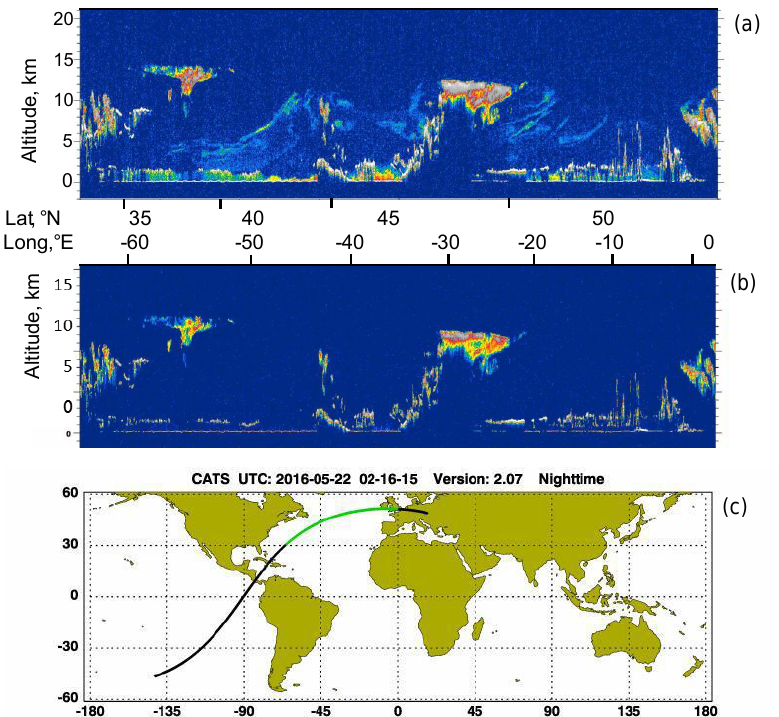
Figure 17. The total attenuated backscatter (a) and perpendicularly polarised backscatter (b) signals from the CATS lidar around 02:16 on 22 May, adapted from figures on the CATS website. Colours are the same as CALIPSO (Fig. 14). Also shown is the path of the ISS and (in green) where the measurements were taken (c)